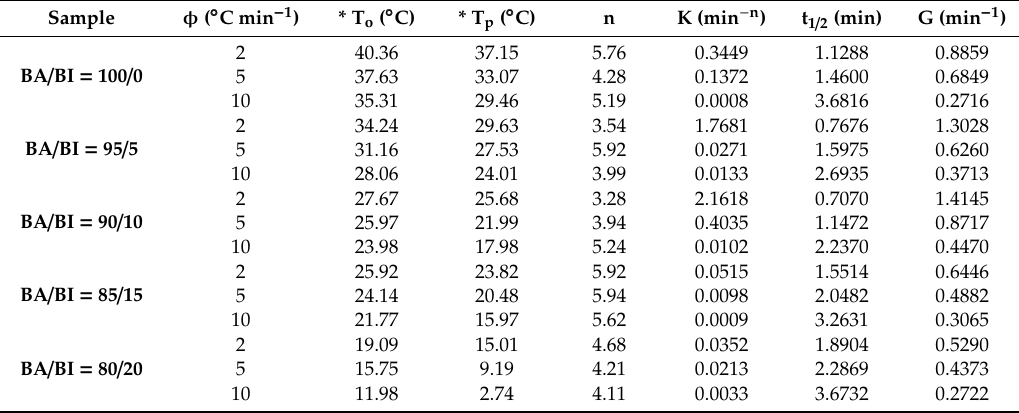
Table 4. Non-isothermal crystallization parameters of PBABI copolyesters with varying BA / BI ratios at di ff erent cooling rates.